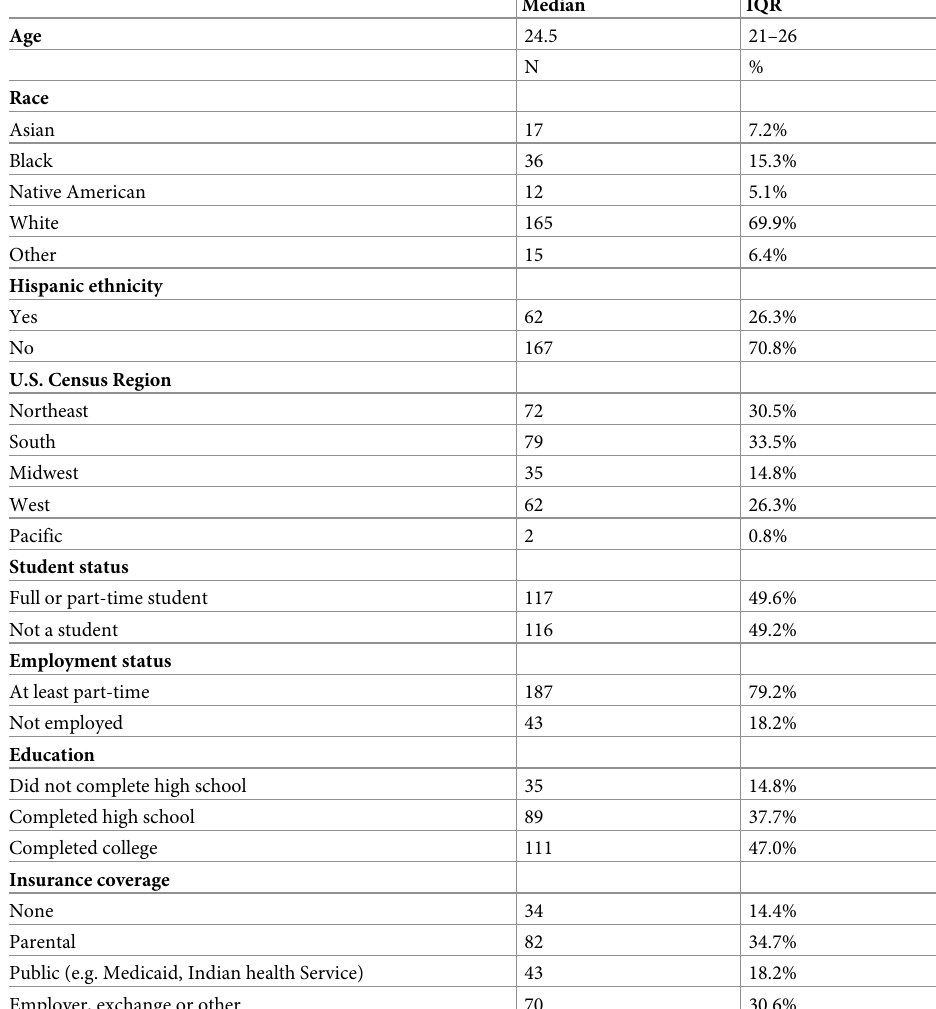
Table 2. Sociodemographic characteristics of 236 PrEP eligible young men who have sex with men from an online survey in the